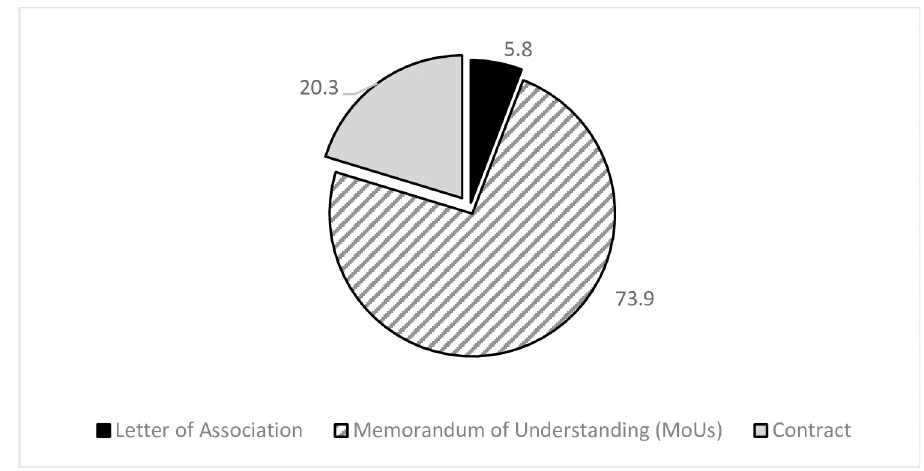
Fig 6. Distribution of the partnerships as per their legal form.